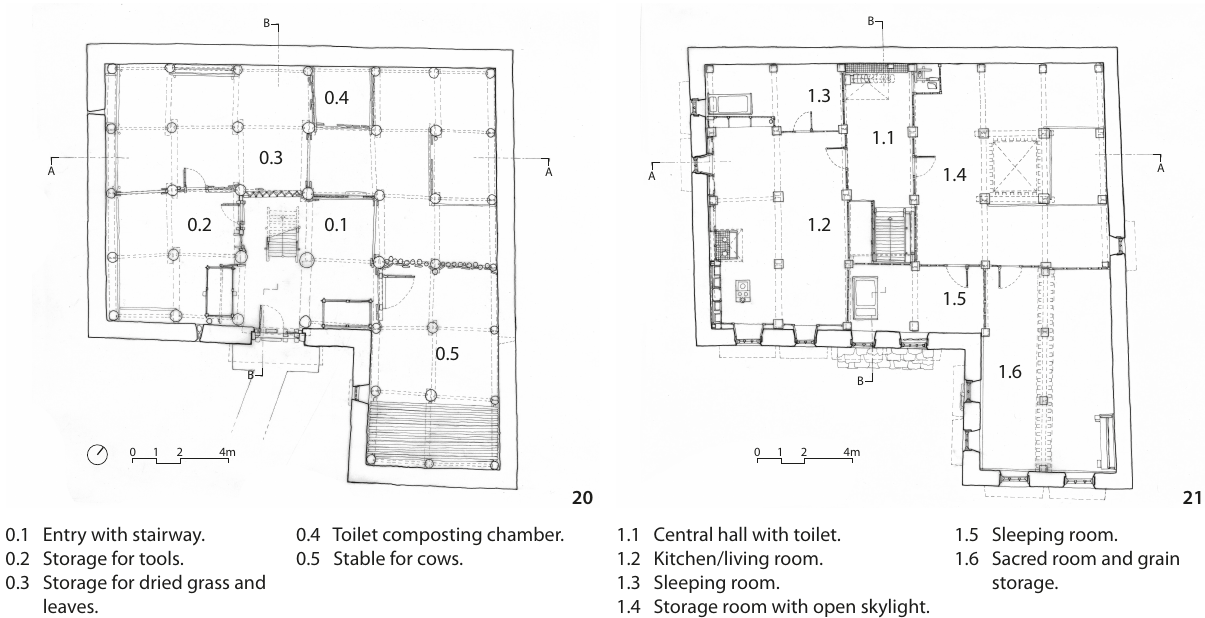
Figure 20 Ground floor plan of the farmhouse in Dabpa (Source: the authors). Figure 21 First floor plan of the farmhouse in Dabpa (Source: the